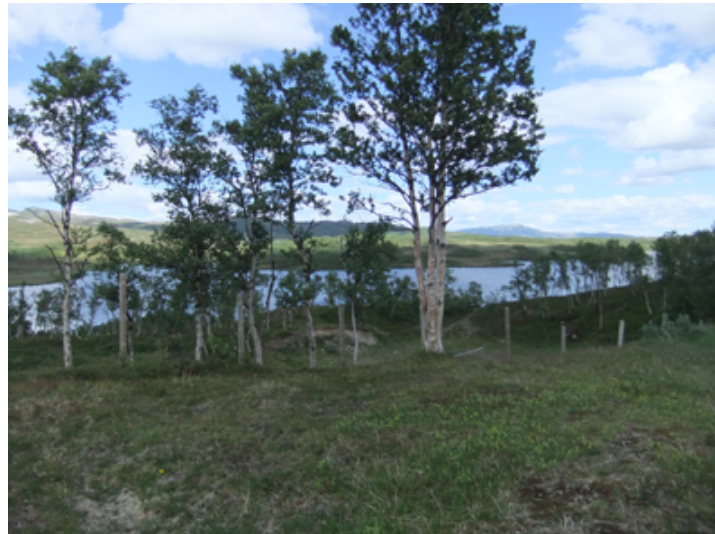
Figure 7. Classic nature (Study